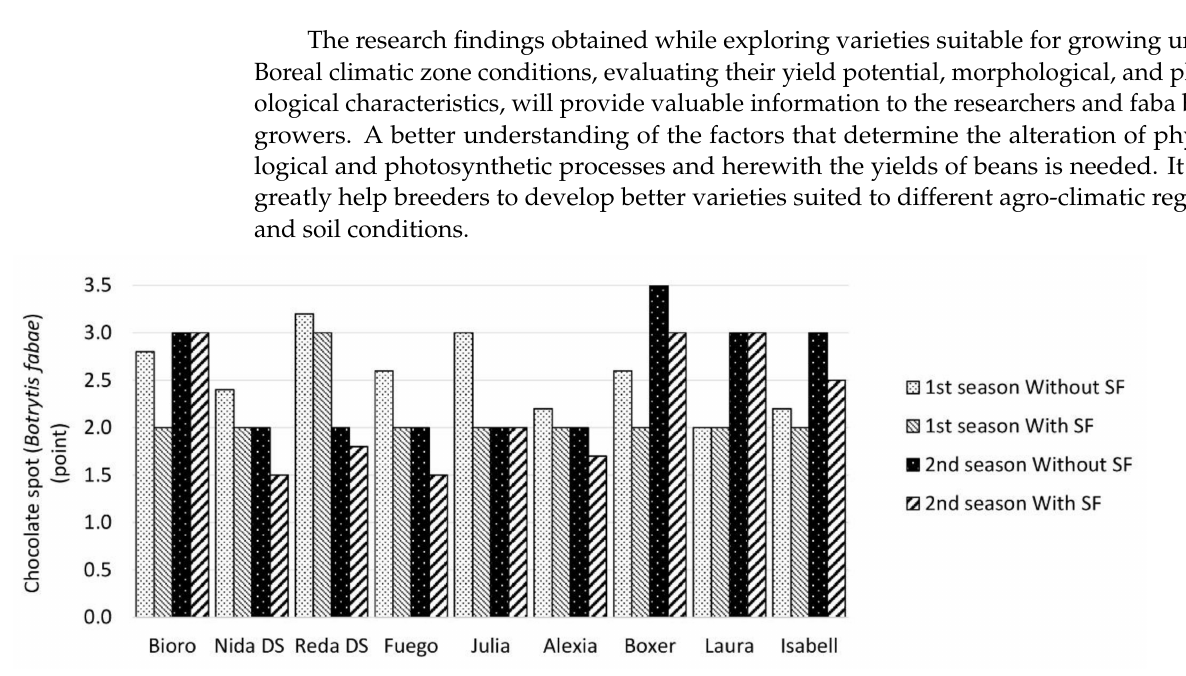
Figure 4. Effects of seed fungicide (SF) on chocolate spot ( Botrytis fabae Sard.) in faba bean